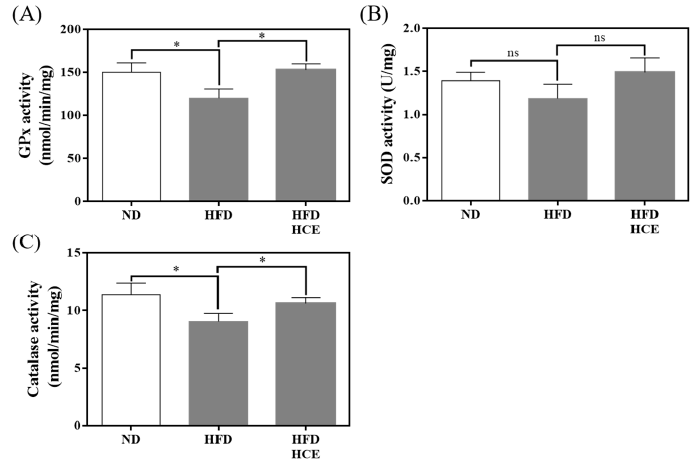
Figure 6. Effect of djulis hull crude extract on the antioxidant enzyme activities of ( A ) glutathione peroxidase (GPx), ( B ) superoxide dismutase (SOD), and ( C ) catalase (CAT) in the liver. ND: normal diet; HFD: high-fat diet; HCE: high dosage of crude extract. Values represent the mean ± SEM ( n = 6). The statistical methods used an unpaired one-tailed Student’s t -test. Significant differences between two different groups are indicated; * p < 0.05, ns = not significant.